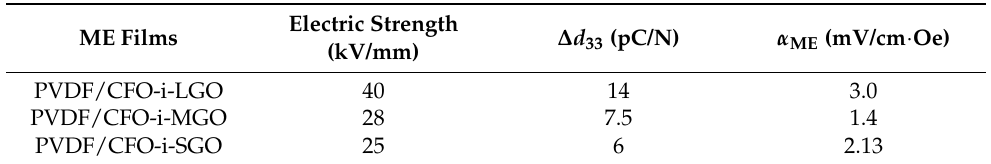
Table 5. Electric strength, piezoelectric, and ME properties in the 3-2 type ME films of PVDF/CFO-i- LGO, PVDF/CFO-i-MGO, and PVDF/CFO-i-SGO.